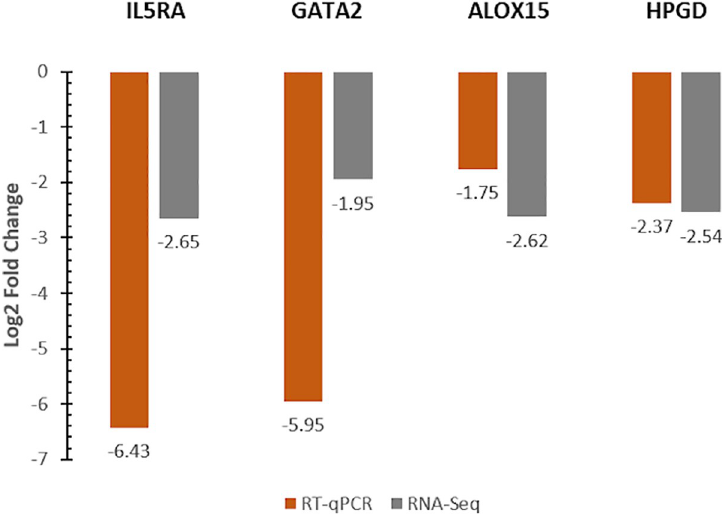
Fig 6. Gene expression validation via RT-qPCR, compared with relative log2 fold change calculated from RNA-Seq analysis. RT-qPCR analysis was normalized with the expression levels of the endogenous reference genes DDX31 and